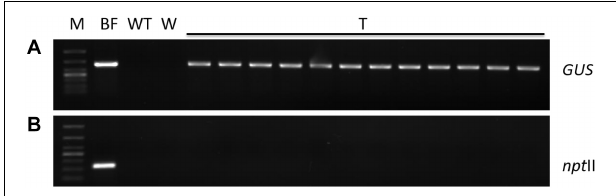
FIGURE 5 | Molecular detection of transgenic embryogenic callus of L. olgensis. PCR amplification of (A) GUS and (B) npt II gene in A. tumefaciens GV3101 containing pCAMBIA1301, untransformed wild-type (WT), and hygromycin-resistant callus (T). Lanes from left to right: 1 kb plus DNA ladder, bacterial fluid, WT callus DNA, water control, and resistant callus DNA (T 1 − 12